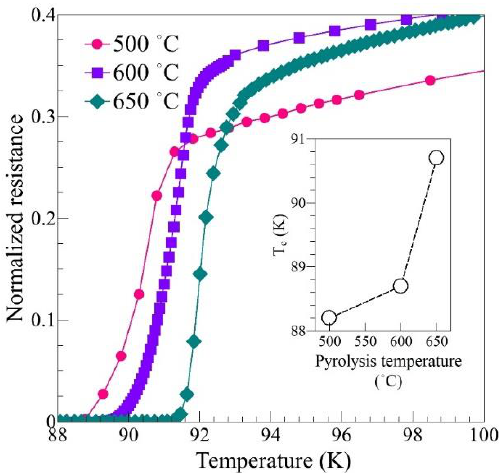
Figure 4. Normalized R ( T ) measurements for the crystallized films, treated at different pyrolysis temperatures; (inset) Variation of the critical superconducting transition temperature T c as a function of pyrolysis temperature.